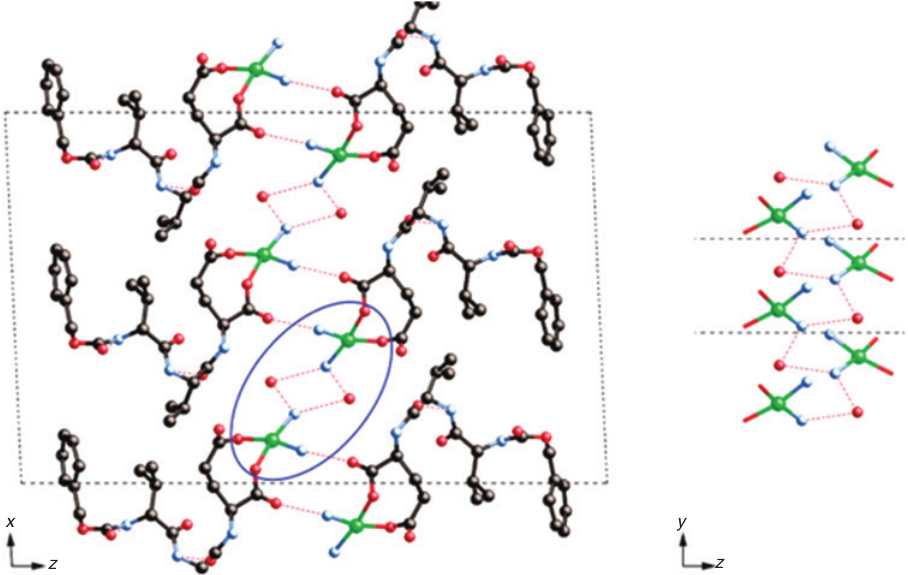
Figure 23: Hydrogen bonding network in the ac plane (left) and perpendicular view to the helical pathway between water molecules and ammonia according to [010] (right). The hydrogen atoms are omitted. Reprinted with permission from [167]. Copyright 2008 American Chemical